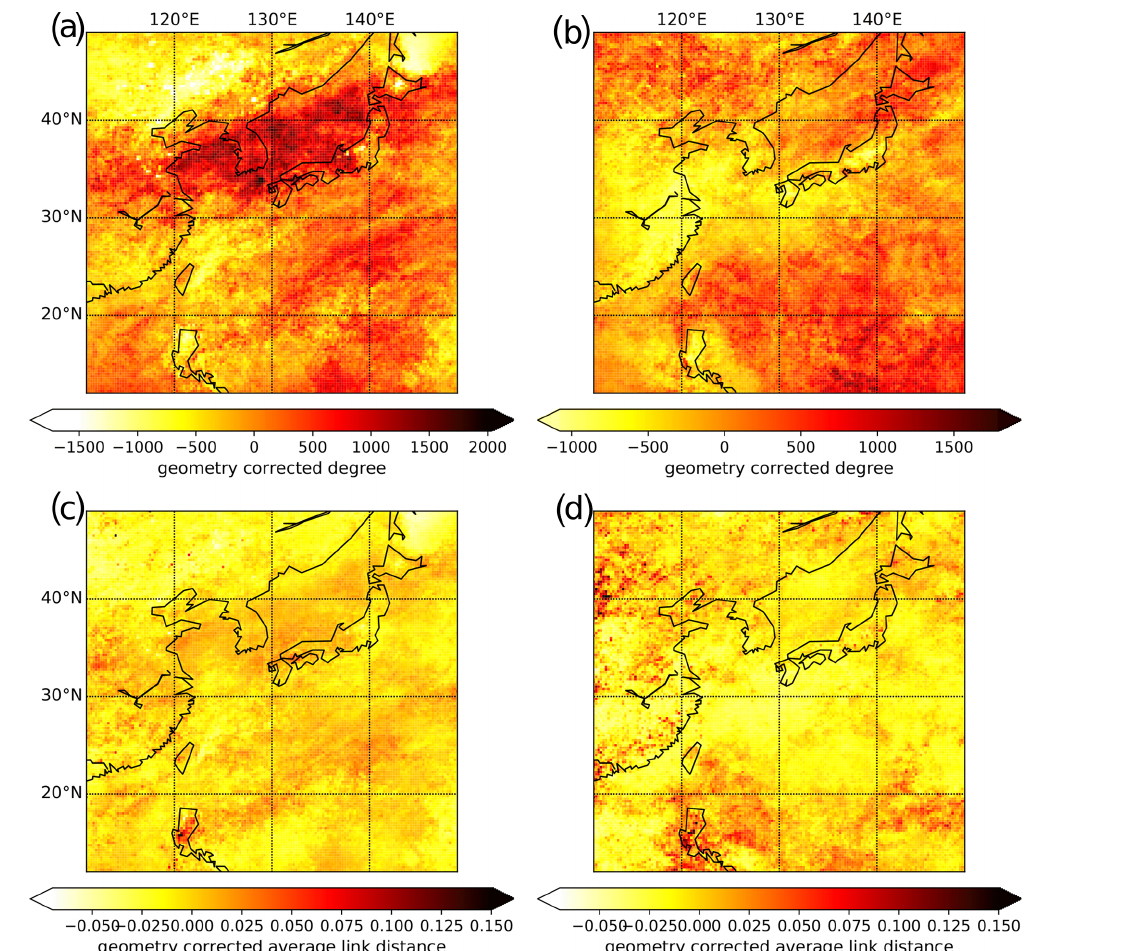
Figure 4. Network evolution before (April, a and c ) and after (August, b and d ) the active Baiu phase. (a, b) Geometry-corrected node degree and (c, d) average link